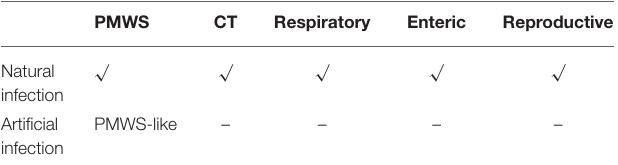
TABLE 2 | Clinical syndromes and diseases associated with P1 virus based on natural or artificial infection or both. PMWS CT Respiratory Enteric Natural infection